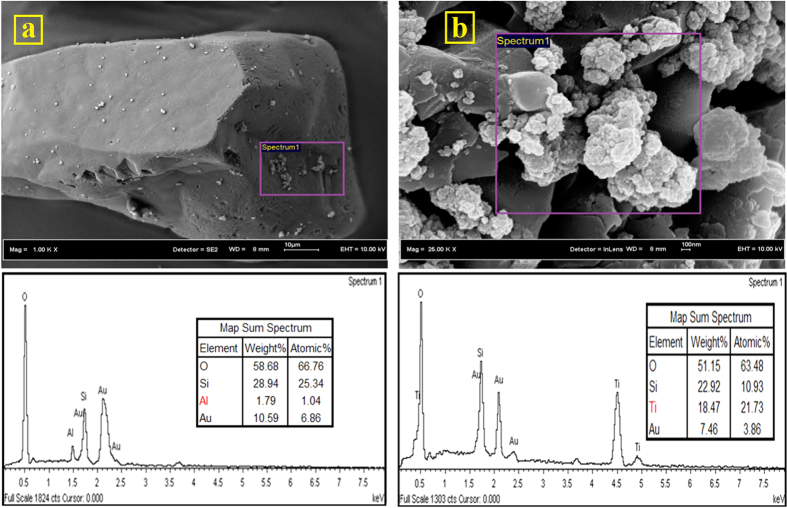
(a) FESEM-EDX analyses from quartz sand grains after the transport experiments, (a) Al2O3-NPs, (b) TiO2-NPs. (The images were taken from grains located in the entrance of columns).